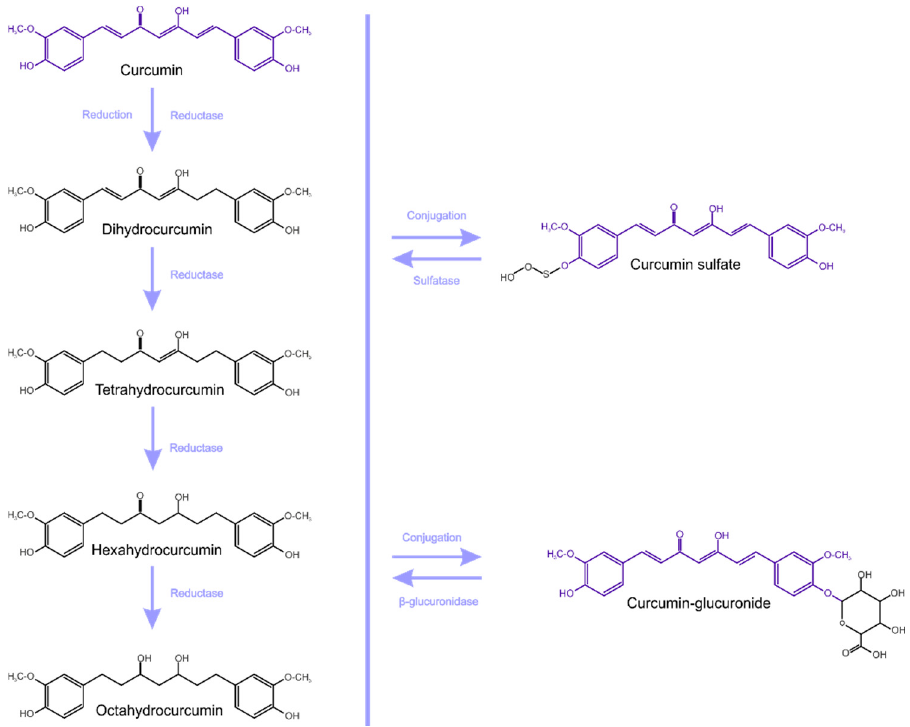
Figure 1. Metabolism of curcumin (conjugation and reduction).